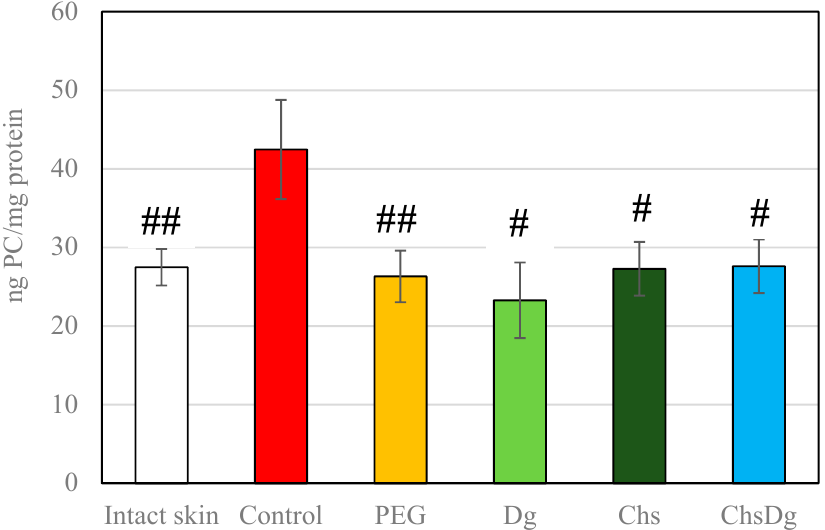
Figure 6. Protein oxidation in intact skin and wound tissues treated with the investigated substances; #— p < 0.05, ##— p < 0.01 vs. control.